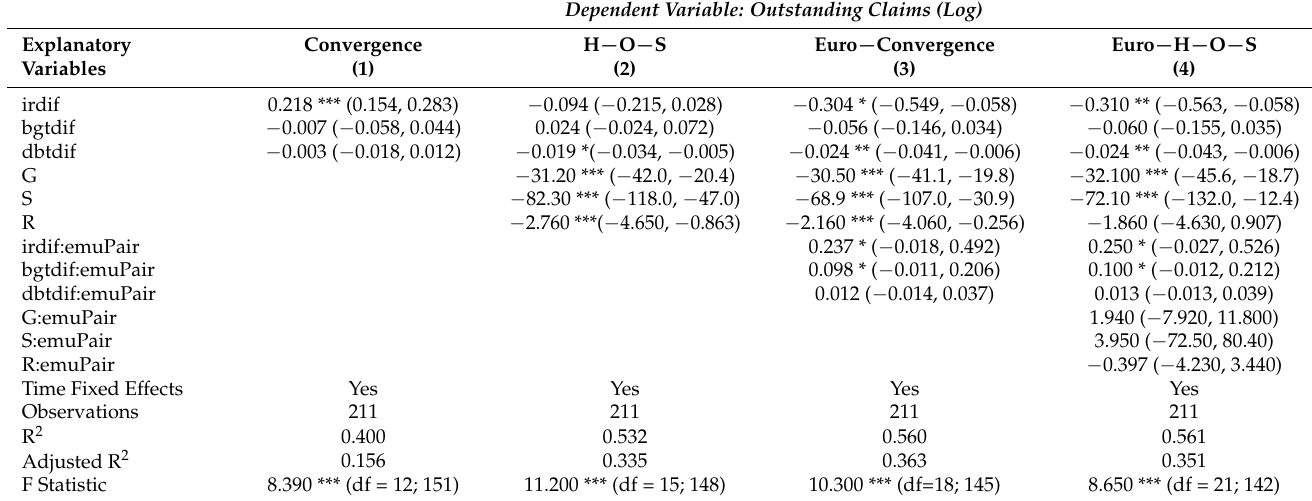
Table 2. Regression